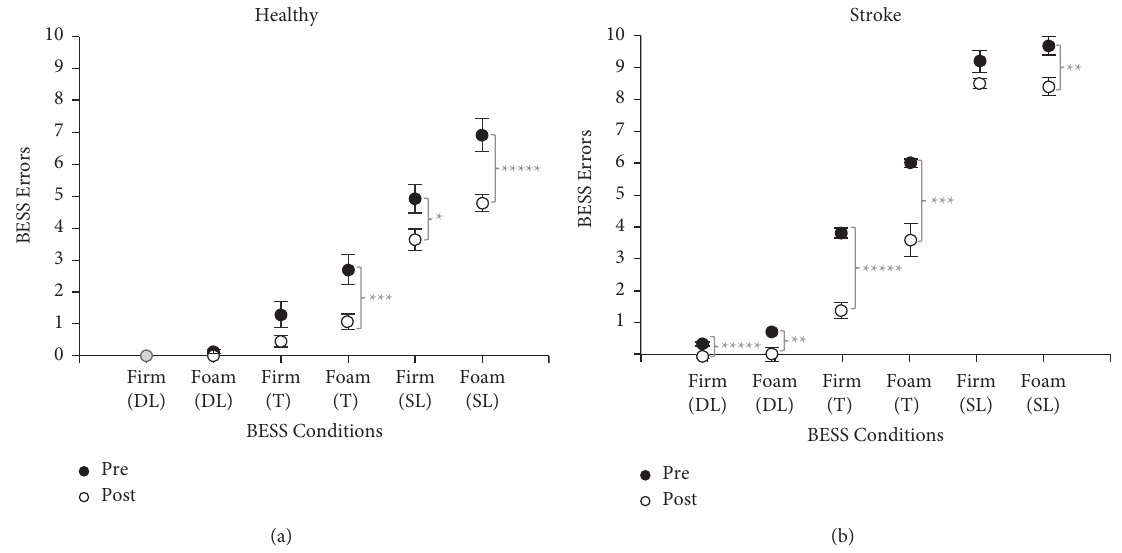
Figure 1: (a) 27 healthy and (b) 7 chronic stroke participants’ BESS errors before (filled circle) versus after (open circle) training as a function of BESS test conditions (stances: DL � double leg, T � tandem, SL � single leg; support surface: firm or foam); means and standard errors are shown. Significance levels are shown as ∗ p < 0 . 05 , ∗∗ p < 0 . 02 , ∗∗∗ p < 0 . 01 , ∗∗∗∗ p < 0 . 002 , ∗∗∗∗∗ p < 0 .